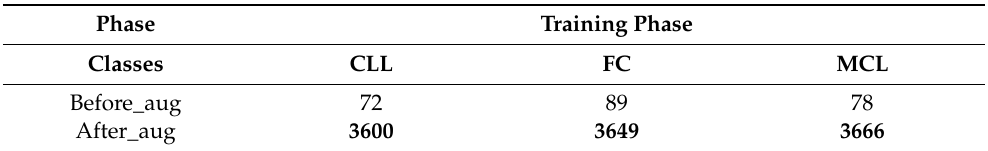
Table 2. The method for augmenting the histological images and balancing the second dataset for malignant